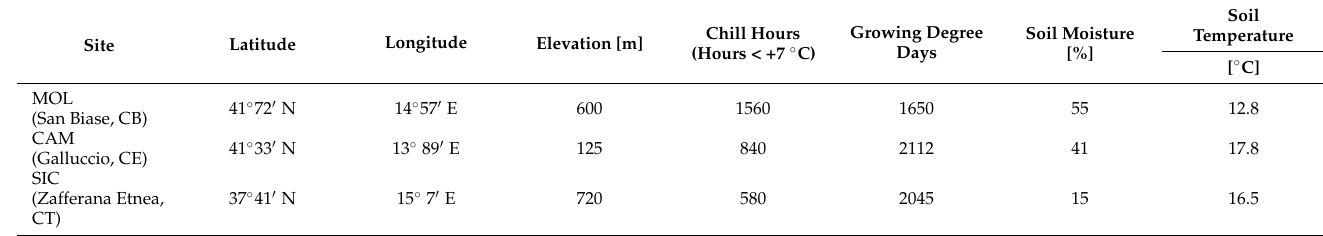
Table 1. Geolocations and data relating to chill hours (from 1 October to 28 February), growing degree days calculated from local meteorological data for the years 2020–2021, soil moisture, and temperature (averaged along soil profiles), from 1 April to 31 October, in the three locations: Molise (MOL), Campania (CAM), and Sicily